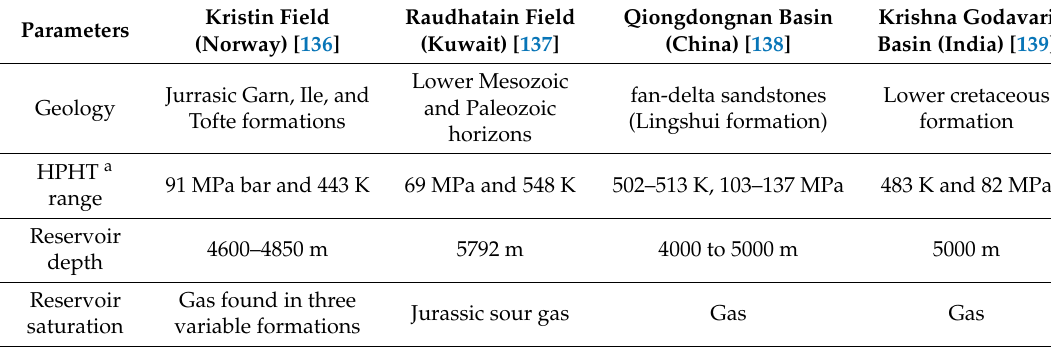
Table 6. Geology and reservoir saturation of high pressure high temperature (HPHT)